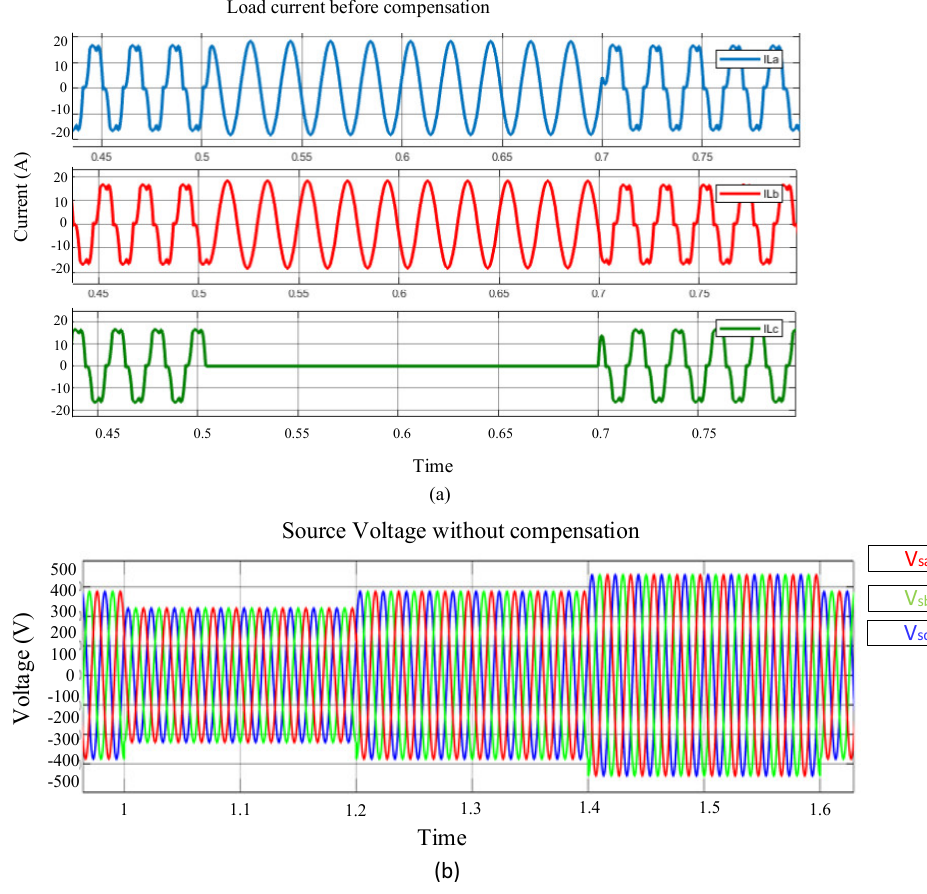
Figure 16. ( a ) Load current before compensation, ( b ) source voltage without compensation.